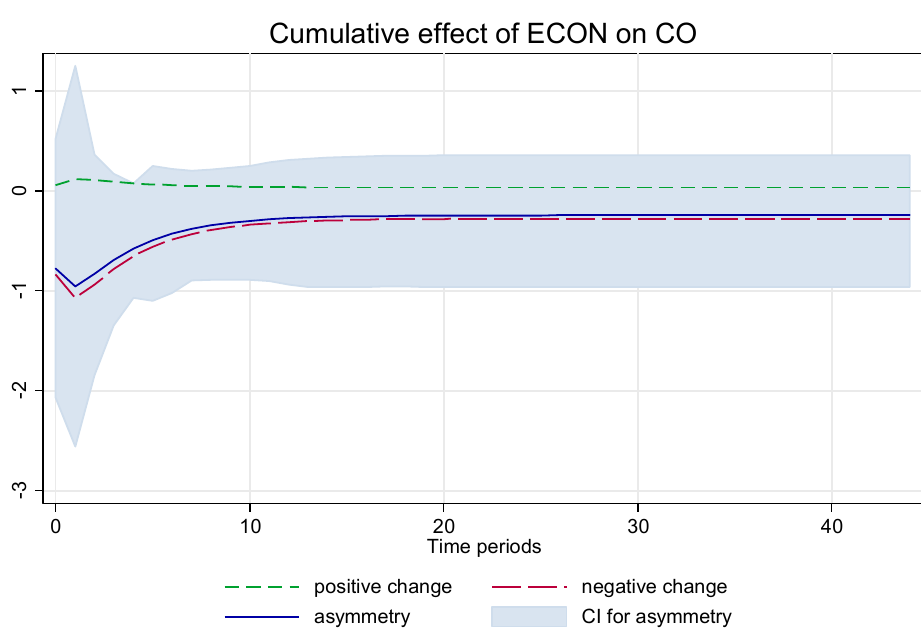
Figure A5. Cumulative effect of ECON on CO.